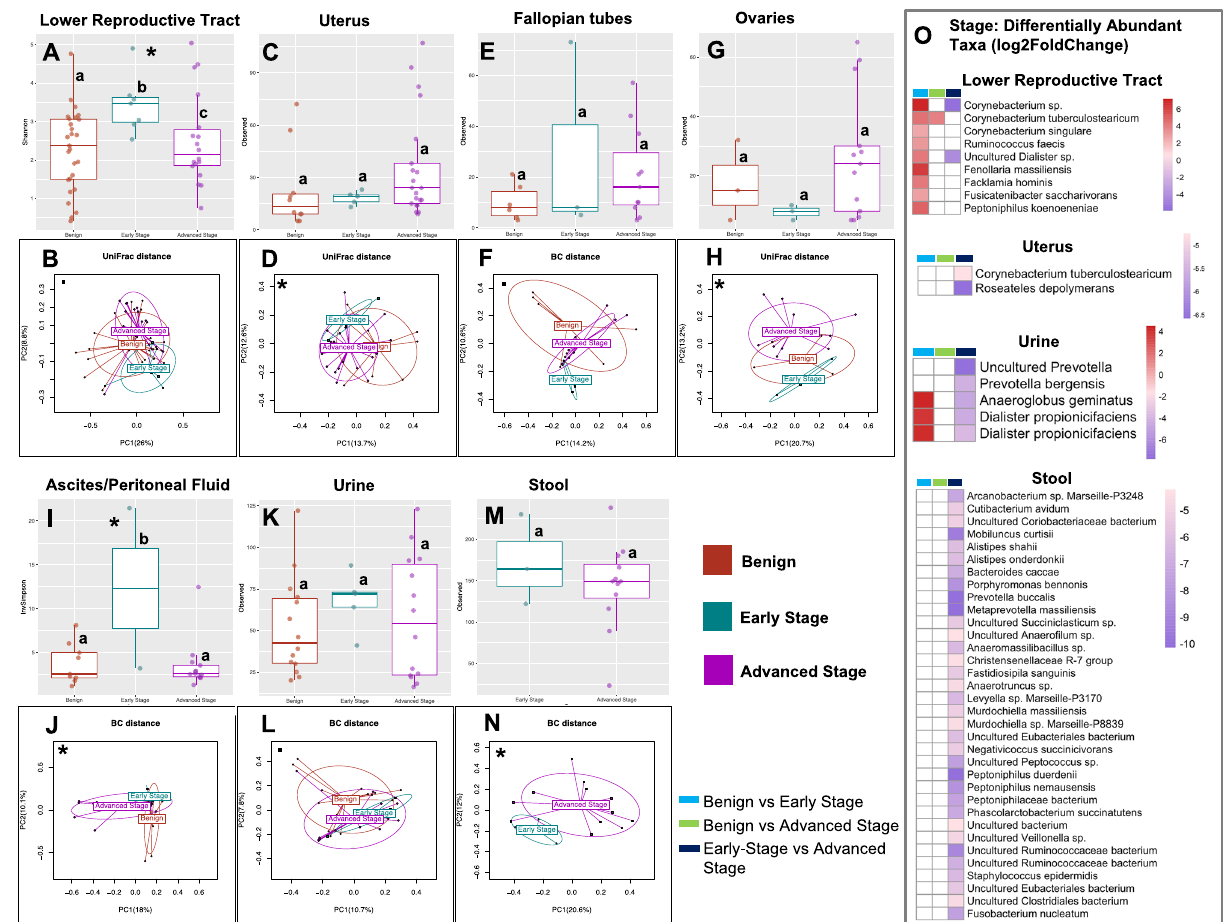
Figure 3. Bacterial community α- and β-diversities among patients with and without different stages of Ovarian Cancer (OC). Both α- and β-diversity measures were compared. For α-diversity a Wald statistical test was performed and Observed ASVs, Shannon Index and Inverse Simpson were reported. For β-diversity, Bray–Curtis (BC), unweighted, weighted, and generalized UniFrac distance metrics were reported. The most significant metric is shown in each ordination plot. Lower reproductive tract (cervix and vagina), ( A ) α-diversity: Benign vs Early stage ( p = 0.019), Advanced stage ( p = 0.025), ( B ) β-diversity: Benign vs Early stage ( p = 0.061), Advanced stage ( p = 0.059), Early vs Advanced stage ( p = 0.065). Uterus, ( C ) α-diversity: Benign vs Early stage ( p = 0.461), Advanced stage ( p = 0.105), ( D ) β-diversity: Benign vs Early stage ( p = 0.002), Advanced stage ( p = 0.006), Early vs Advanced stage ( p = 0.284). Fallopian tube, ( E ) α-diversity: Benign vs Early stage ( p = 0.384), Advanced stage ( p = 0.196), ( F ) β-diversity: Benign vs Early stage ( p = 0.127), Advanced stage ( p = 0.127), Early vs Advanced stage ( p = 0.078). Ovaries, ( G ) α-diversity: Benign vs Early stage ( p = 0.872), Advanced stage ( p = 0.447), ( H ) β-diversity: Benign vs Early stage ( p = 0.433), Advanced stage ( p = 0.240), Early vs Advanced stage ( p = 0.039). Ascites/Peritoneal fluid, ( I ) α-diversity: Benign vs Early stage ( p = 0.054), Advanced stage ( p = 0.010), ( J ) β-diversity: Benign vs Early stage ( p = 0.166), Advanced stage ( p = 0.028), Early vs Advanced stage ( p = 0.091). Urine, ( K ) α-diversity: Benign vs Early stage ( p = 0.310), Advanced stage ( p = 0.380), ( L ) β-diversity: Benign vs Early stage ( p = 0.175), Advanced stage ( p = 0.086), Early vs Advanced stage ( p = 0.566). Stool, ( M ) α-diversity: Benign vs Advanced stage ( p = 0.302), ( N ) β-diversity: Early vs Advanced stage ( p = 0.042). ( O ) Heatmaps showing the effect size (Log 2 Fold Change) of the differentially abundant microbial taxa. White boxes reflect no fold change at FDR < 0.10. Analysis was adjusted for menopause status, and BMI. Samples rarefied prior to analysis. Wald statistical test with Q value cutoff = 0.1. *Groups are significantly